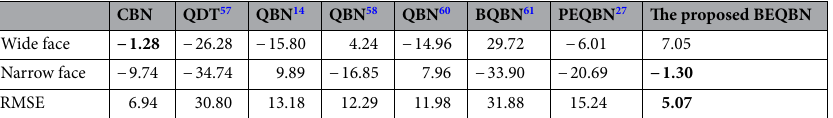
Table 6. Errors between the empirical results and predicted probability of taking defensive action without categorization based on eight predictive models including CBN, QDT 57 , QBN 14 , QBN 58 , QBN 60 , BQBN 61 , QBN 27 , and the proposed BEQBN model in this study. Significant values are in